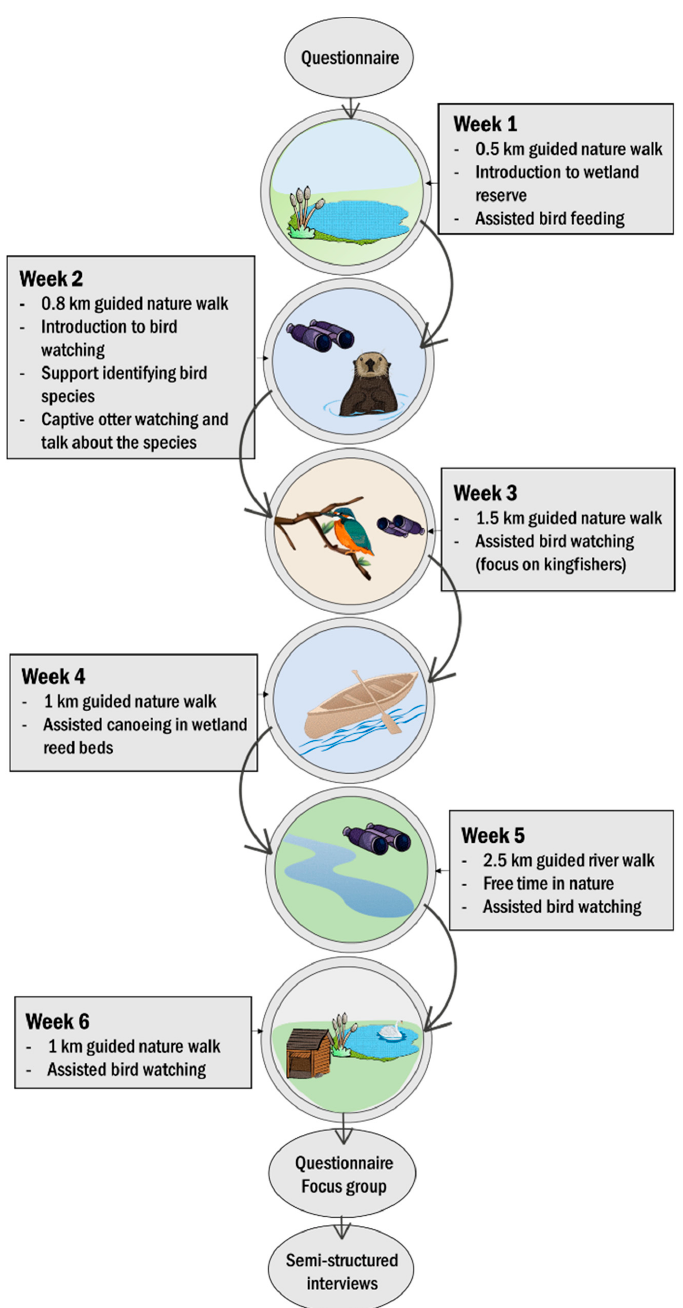
Figure 2. The structured six-week nature-based health intervention (NBI) consisted of a broad range of nature-focused activities that took place within a wetland site. Wetland NBI activities (square boxes) were guided by a minimum of two wetland site staff and one mental health support worker. Data collection activities (circles) included a questionnaire self-reporting on indicators of mental health before and after the six-week intervention, as well as a participant focus group. Interviews were conducted with the two mental health support workers after the wetland NBIs were